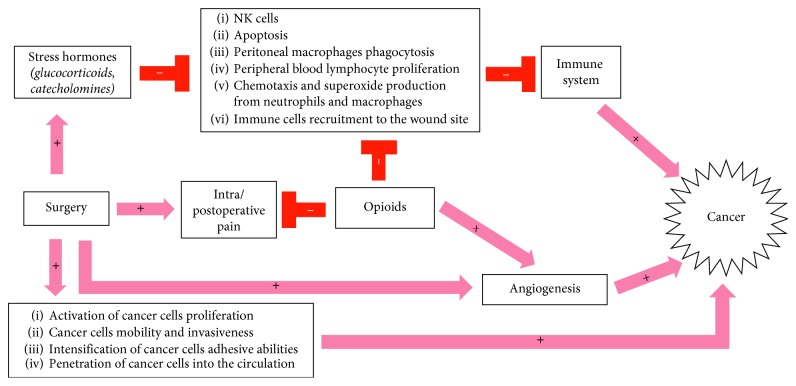
Perioperative immunosuppression mechanisms [16–23].